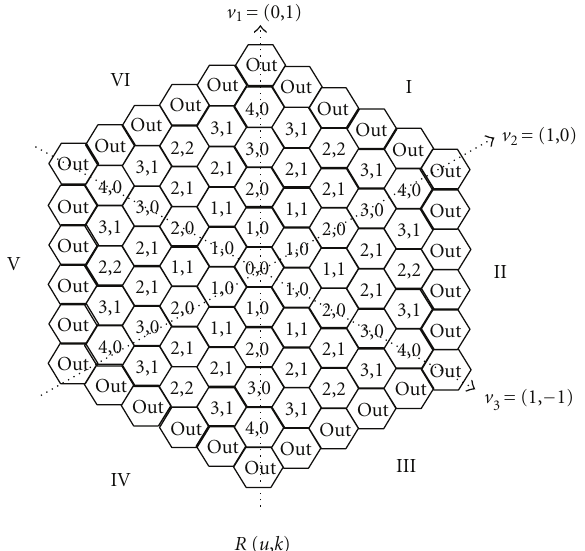
Figure 2: Relative Moving Distance Model: R ( u , k ) .